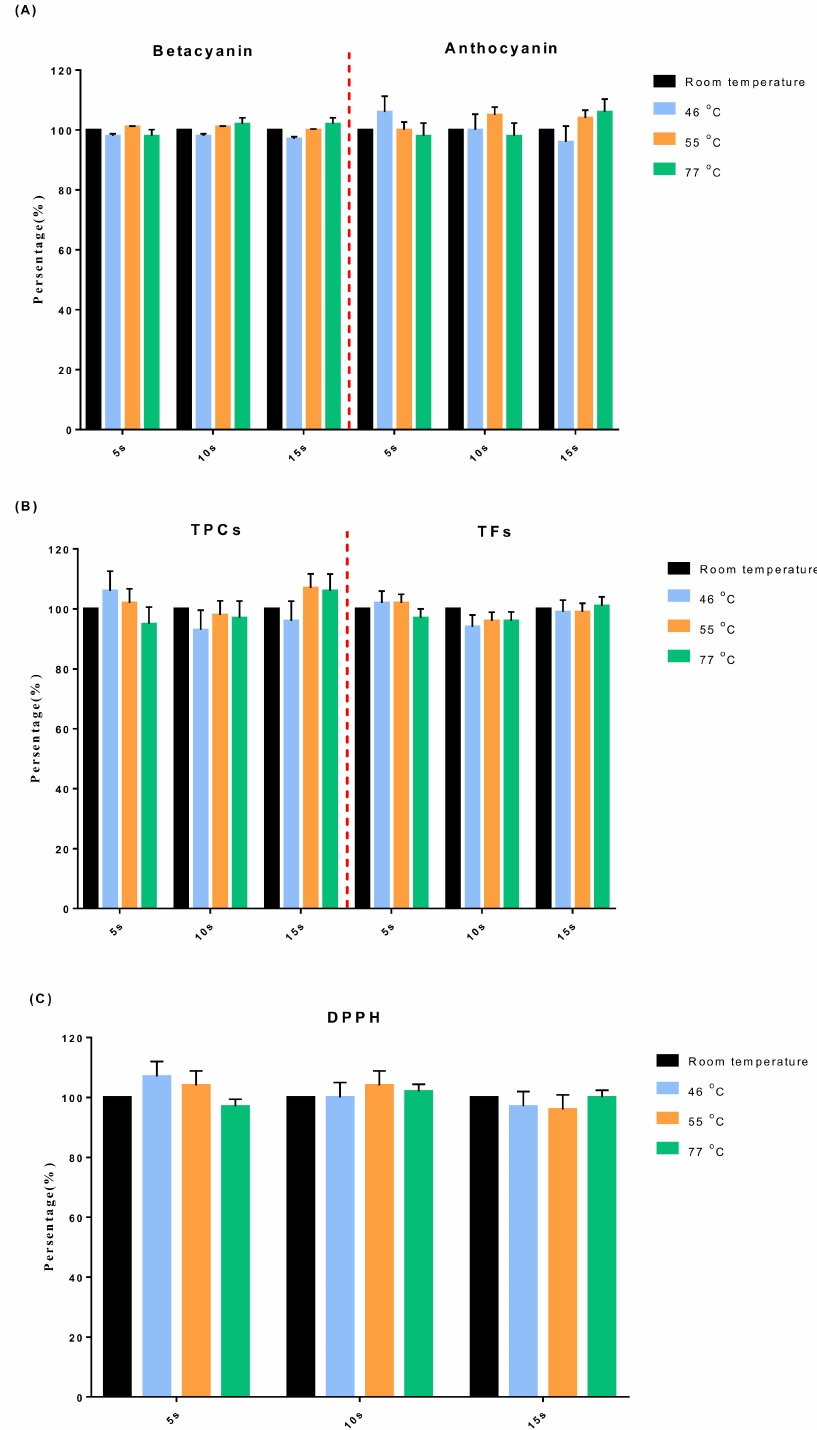
Figure 6. Examination of thermal effects on the djulis seeds heated by oven. The oven temperature was controlled at room temperature and 46, 55, and 77 ◦ C and the contact times tested were 5, 10, and 15 s. The fold increases of bioactive compounds of the djulis seed under the thermal treatment were obtained over those in the non-thermal control (room temperature): ( A ) betacyanin and anthocyanin; ( B ) TFCs and TFs; and ( C )